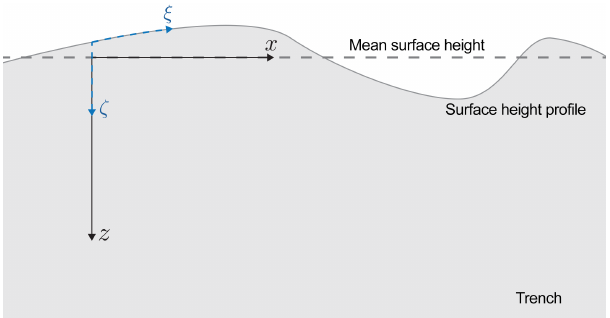
Figure 1. Coordinate systems used for the analysis of the trench isotope data: (1) a curvilinear coordinate system ( ξ,ζ ) (blue dashed lines, surface coordinates) with horizontal axis along the surface height profile and vertical axis denoting the depth below the local surface; (2) a Cartesian system ( x,z ) (black lines, absolute coordi- nates) defined by the mean surface